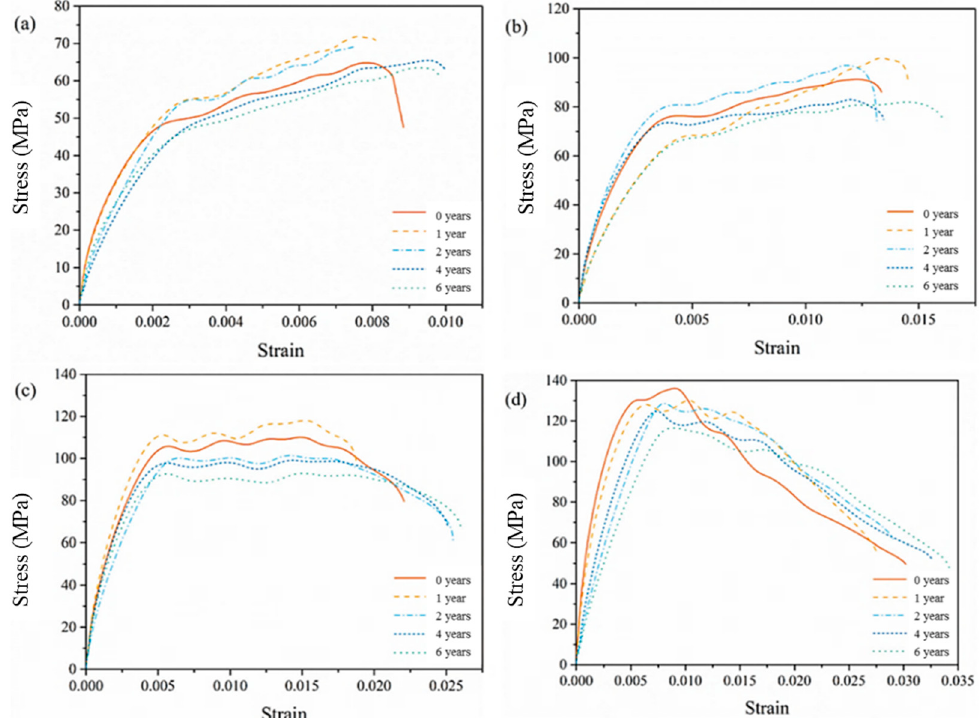
Figure 8. Average compression stress-strain curves with different equivalent aging time under different impact velocities: ( a ) 12.2 m/s, ( b ) 18.8 m/s, ( c ) 25.0 m/s, ( d ) 29.2 m/s.